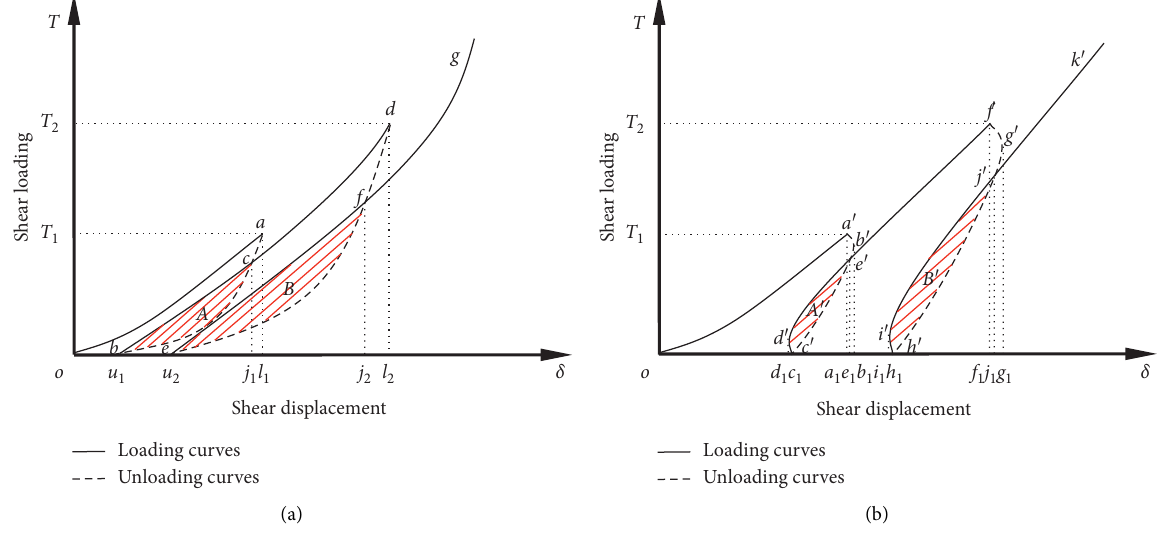
Figure 12: T - δ curves. (a) Ideal. (b)